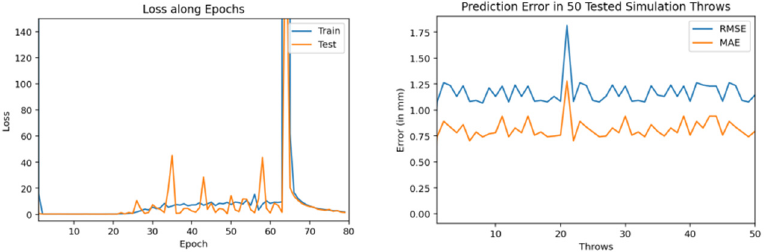
Figure 16. Training and testing results by encoder-decoder bidirectional LSTM deep NN (trained through 3000 throws with 80 epochs and 100 neurons).